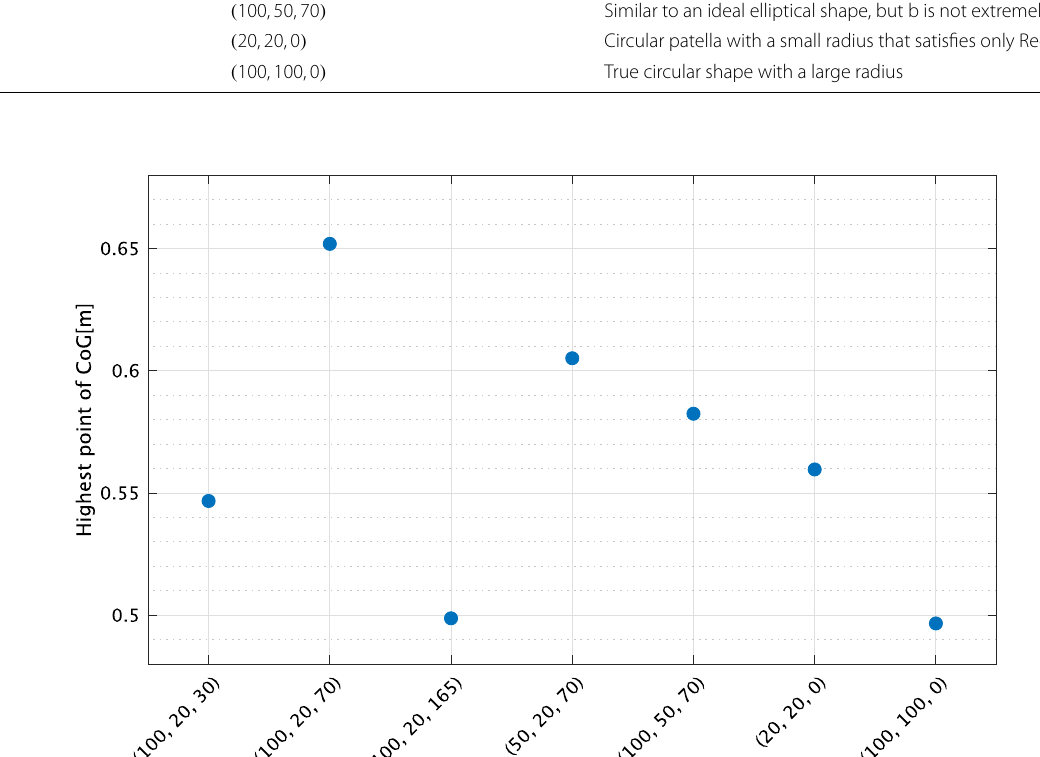
Fig. 8 Highest point reached by the center of gravity in jumping simulations with seven different